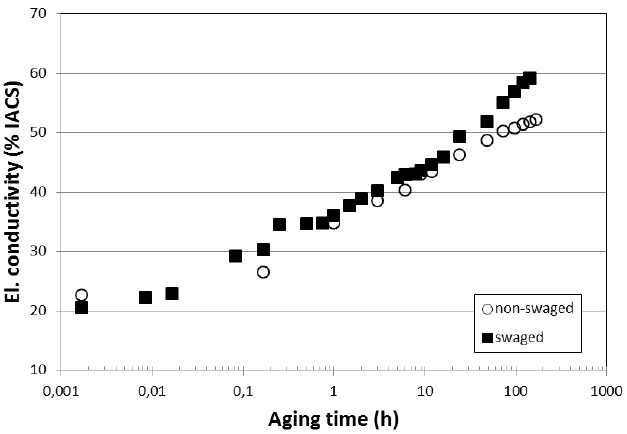
Figure 7. Conductivity vs. aging time for swaged (UFG) and coarse-grained CuNi3Si1Mg ( T = 450